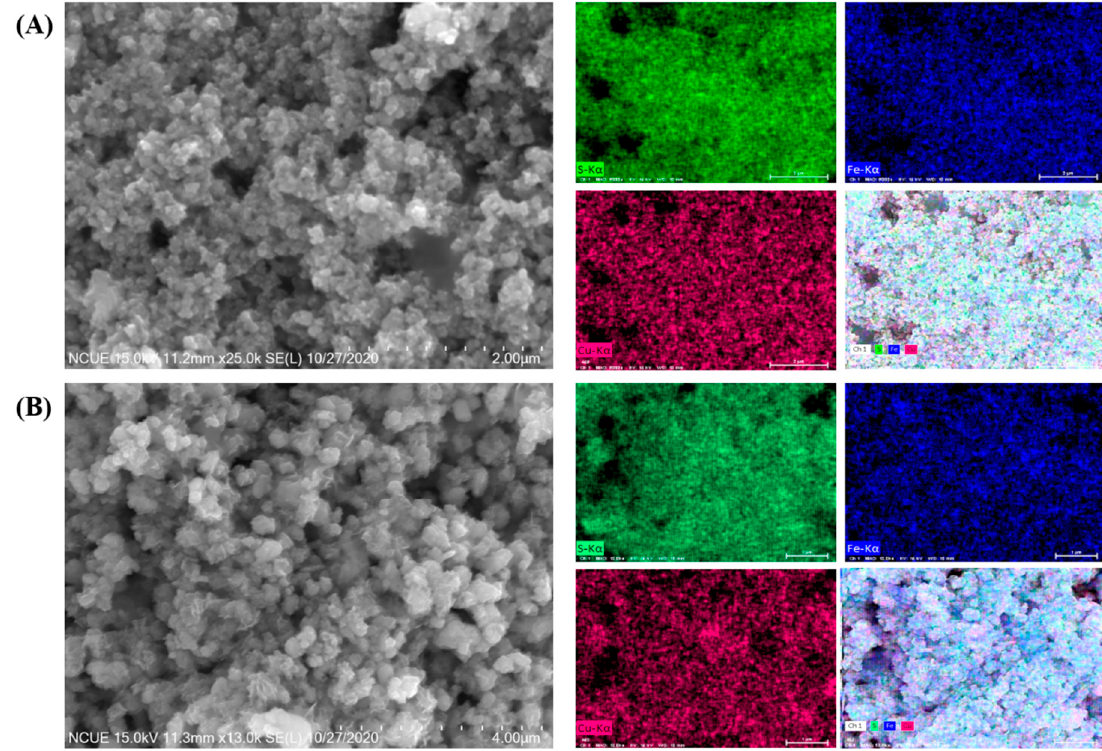
Figure 1. SEM images and EDS-mapping of ( A ) H-CuFeS 2 and ( B ) C-CuFeS 2 samples.